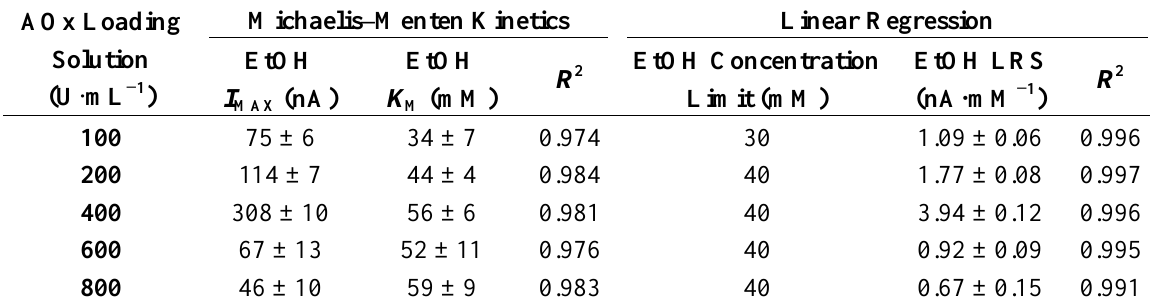
Table 1. Biosensor ethanol response study. In-vitro characterization at Day 1 ( n = 4 for each group) of different biosensor designs with different enzyme loading. Table shows apparent Michaelis−Menten kinetic parameters ( I (LRS) in the reference linear range.